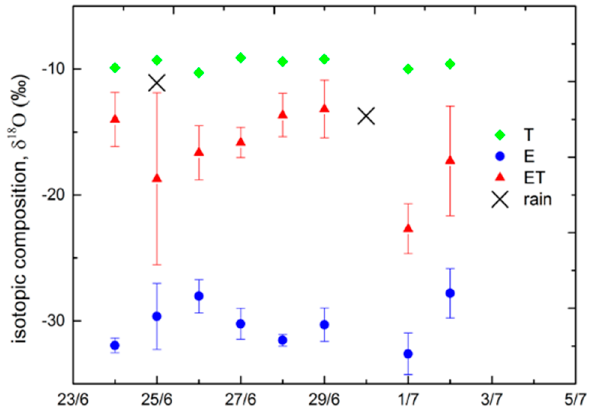
Figure 6. Daily averages of the isotopic composition of the precipitation (black cross) evapotranspiration flux, δ ET (red triangles), soil evaporation flux, δ E (blue circles), and transpiration flux δ T (green diamonds). Error bars depict one standard deviation of measurement.